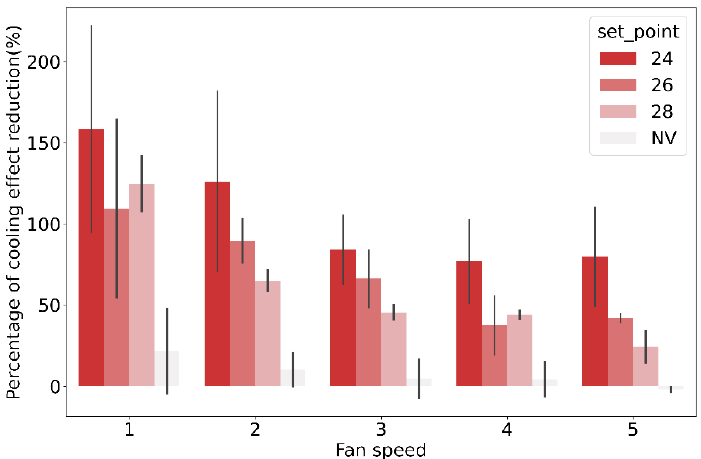
Figure 13. Percentage of negated cooling effect due to rise in indoor operative temperature (right).